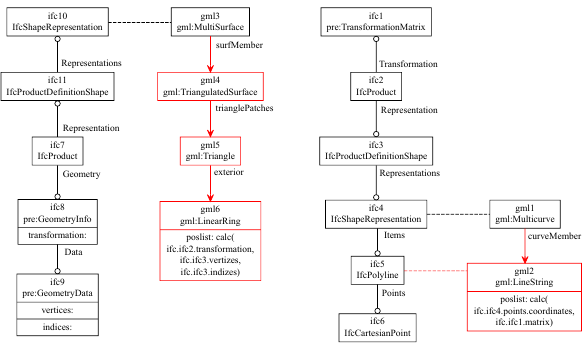
Figure 9. Geometry extraction variants: preprocessed geometry to triangulated surface (A1 and B1, left) or polyline to line string (A2 and B2, right).